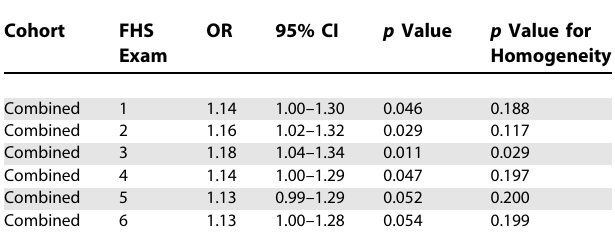
Table 4. Association Studies of rs7566605 C/C Genotype in a Combined Analysis of All Urelated Samples Using One of